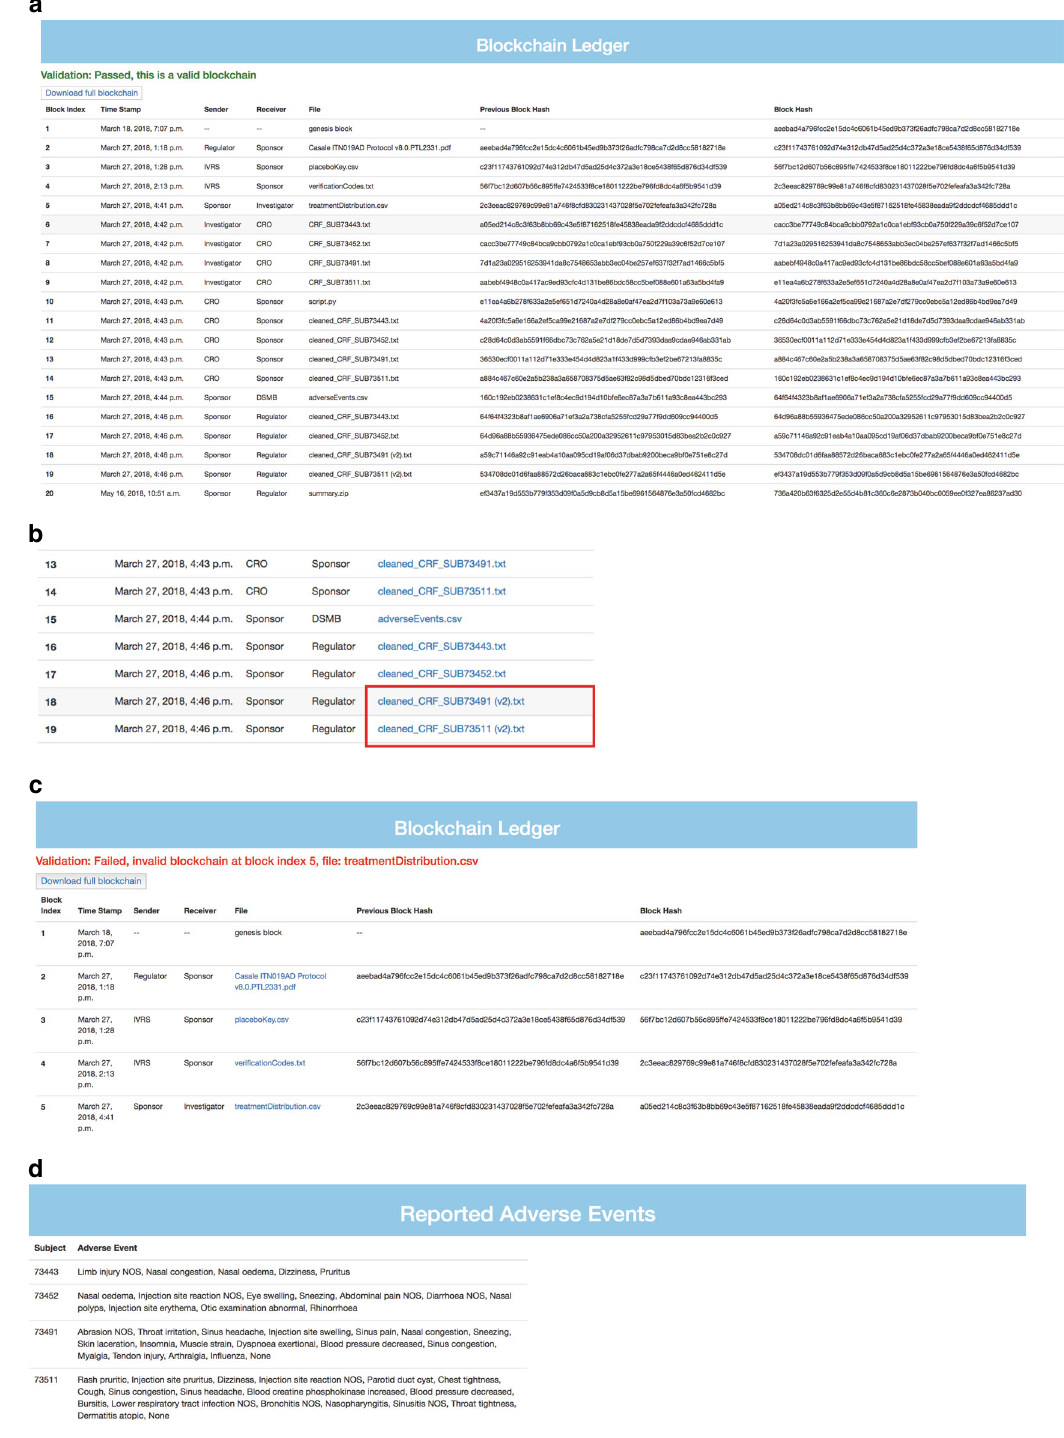
Fig. 3 Portal functionality. a The public ledger shows the full transaction history since the start of the trial. Blocks are timestamped, indexed, and attached with the fi le of the transaction and identities of the participating parties. The regulator can easily download individual fi les, or all elements in bulk, and inspect when and between whom fi les are shared. b New versions of fi les are given a version number, which increments with each new version of that fi le. In the screenshot above, the original CRF was modi fi ed by the sponsor and automatically appended with a (v2) by the system (boxed in red). The responsible party and time of modi fi cation are readily apparent. c Internal validation and automated hash checks take place to verify the integrity of the data without the need to manually read through the data ’ s contents. Hash checks are performed chronologically starting with the genesis block, and verify that the hash of the contents of the block match what is to be expected (see Supplementary Methods). Validation fails when the treatmentDistribution.csv is modi fi ed at the storage level. The precise origin and location of the fault can be readily discerned. d Adverse events are auto populated from investigator uploaded CRFs to the pages of the regulator and DSMB, circumventing the normal, slower, and more error prone pathway that is normally taken for adverse event reporting. Such instances are available for inspection at the soonest possible